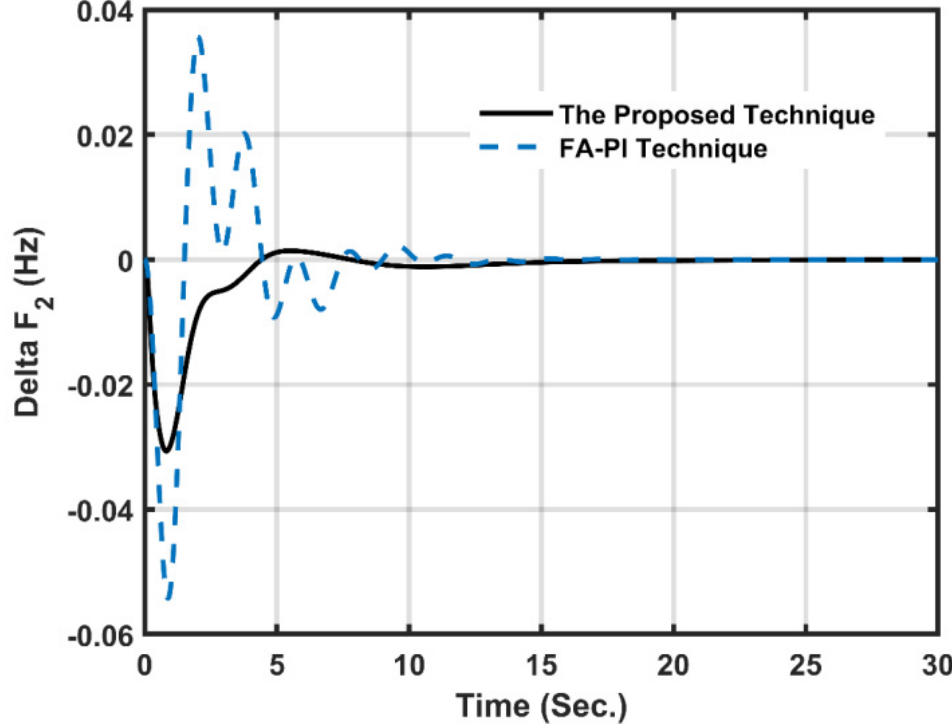
Figure 15. Frequency deviation in area 2 under disturbance in thermal demand.